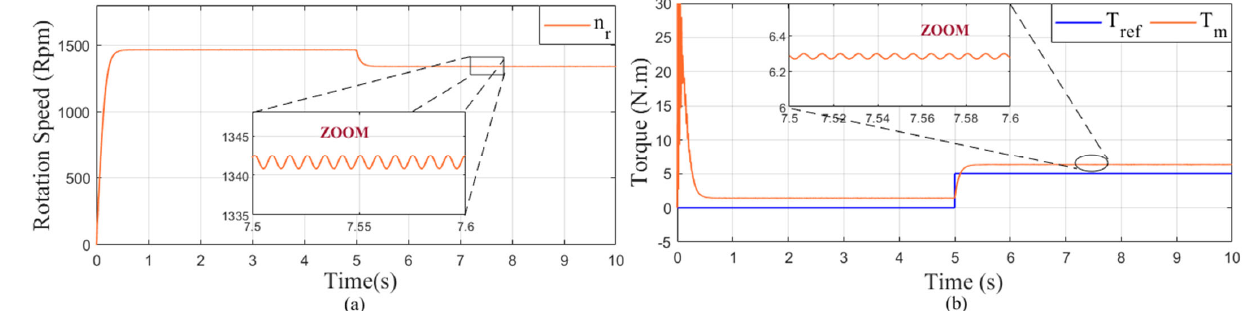
Figure 14. Performance in healthy state of IM without control: ( a ) rotation speed and ( b ) motor torque.